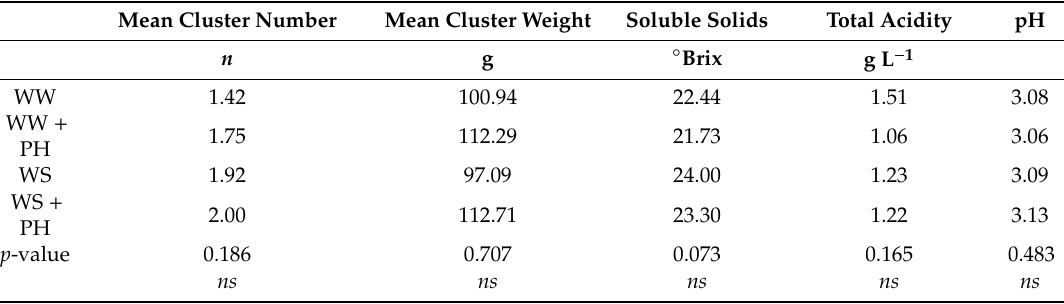
Table 1. E ff ects of water stress (WS) and PH application on cluster numbers, cluster weight, and grape composition at harvest compared with well-watered conditions (WW). Values are means ± SE of 50 berries in three replicates per treatment. ns = no significant di ff erences according to Tukey’s test ( p ≤